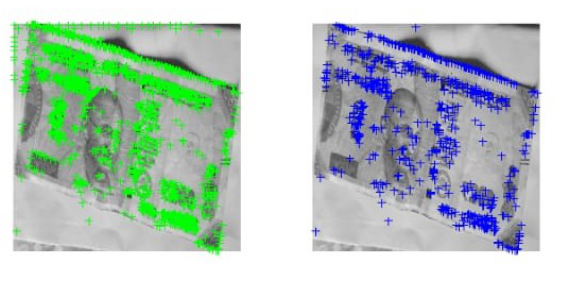
Figure 2. Sift with non crumpled currency